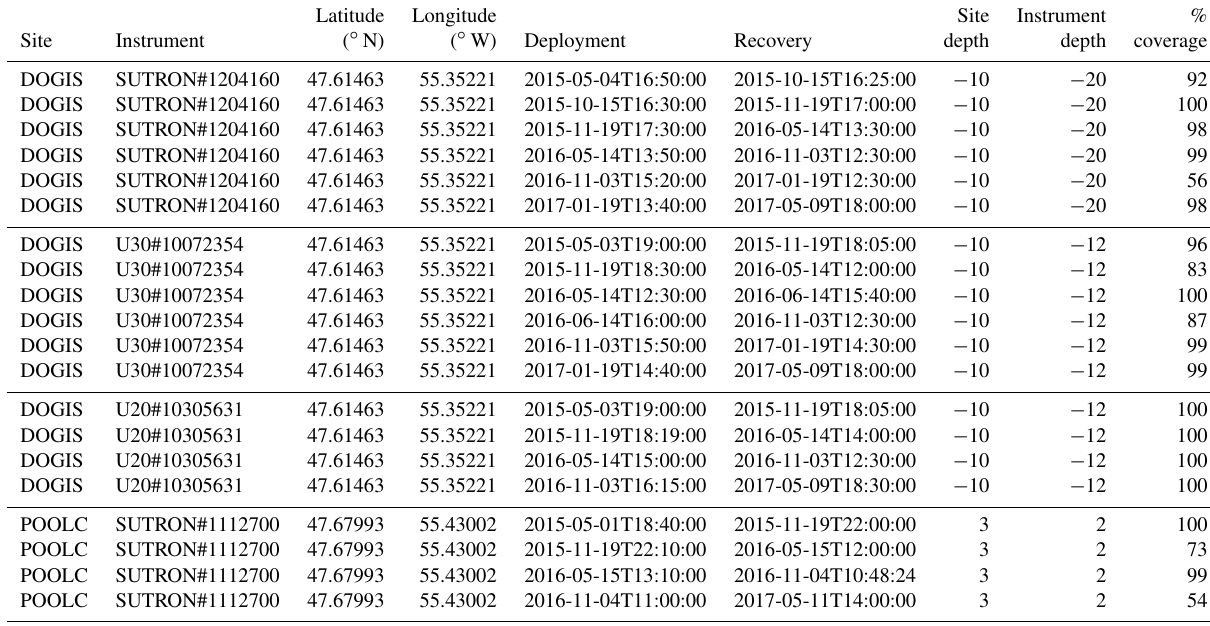
Table B5. Land-based data collection summary for the whole program (May 2015–May